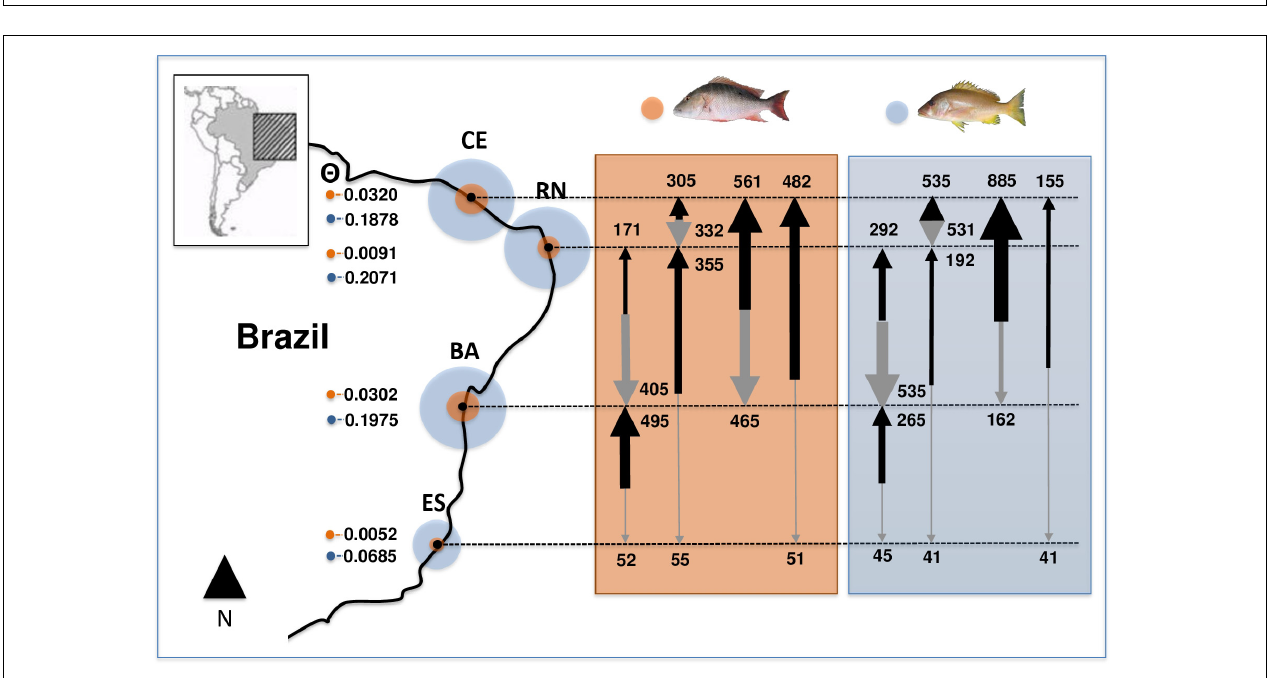
FIGURE 1 | Map of collection points and haplotype networks of Lutjanus analis (A) and Lutjanus jocu (B) . Each haplotype is represented by a circle, color coded according to the population of origin. Circle sizes are related to their respective frequency. Unsampled haplotypes are represented as empty circles, and multi-step differences between haplotypes are represented with an empty circle containing the number of mutation steps.